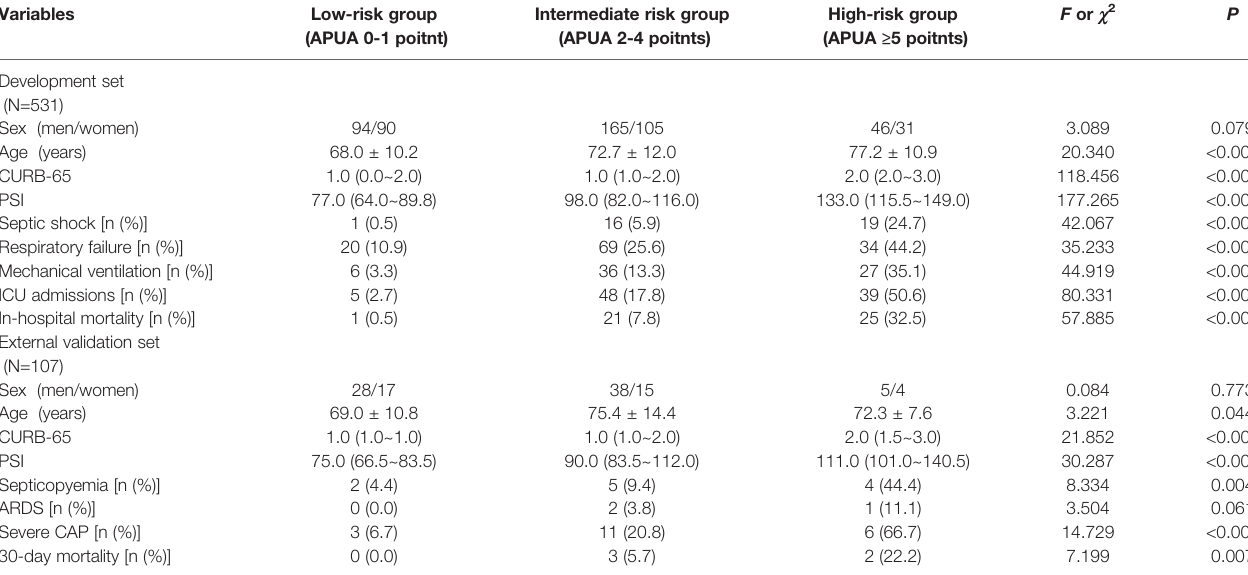
TABLE 2 | Characteristics of community acquired pneumonia patients with different APUA score. Variables